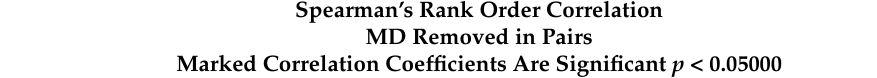
Table 8. Correlation coefficients among serum levels of interleukins and results of personality tests—the study